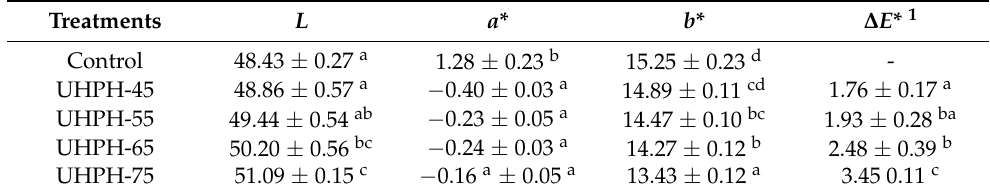
Table 3. Color parameters ( L *, a *, b *, and ∆ E *) in untreated (control) and ultra-high-pressure- homogenized fish broths at 300 MPa at different inlet temperatures (45, 55, 65, and 75 ◦ C). Treatments L a * b * ∆ E * 1 Control 48.43 ± 0.27 a 1.28 ± 0.23 b 15.25 ± 0.23 d - UHPH-45 48.86 ± 0.57 a − 0.40 ± 0.03 a 14.89 ± 0.11 cd 1.76 ± 0.17 a UHPH-55 49.44 ± 0.54 ab − 0.23 ± 0.05 a 14.47 ± 0.10 bc 1.93 ± 0.28 ba UHPH-65 50.20 ± 0.56 bc − 0.24 ± 0.03 a 14.27 ± 0.12 b 2.48 ± 0.39 b UHPH-75 51.09 ± 0.15 c − 0.16 a ± 0.05 a 13.43 ± 0.12 a 3.45 0.11